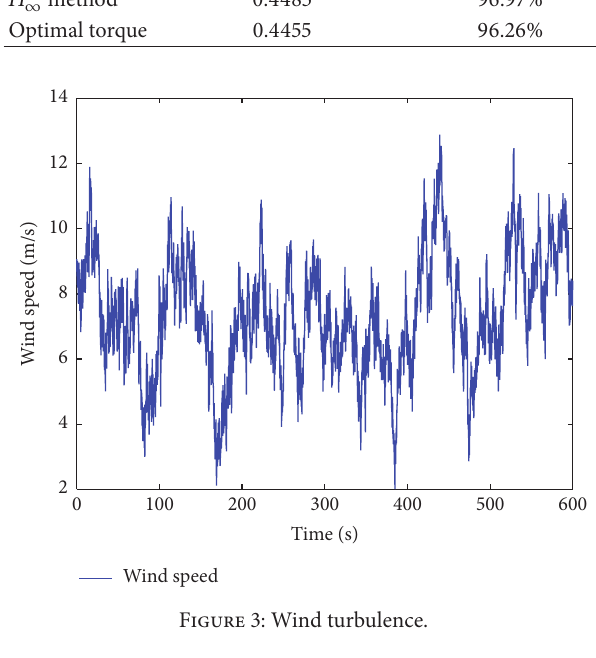
Figure 3: Wind turbulence.